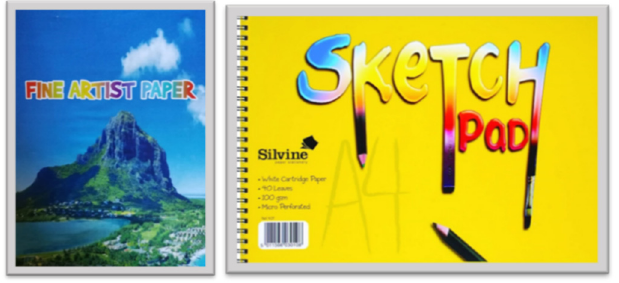
Figure 1. Students’ sketch pad.